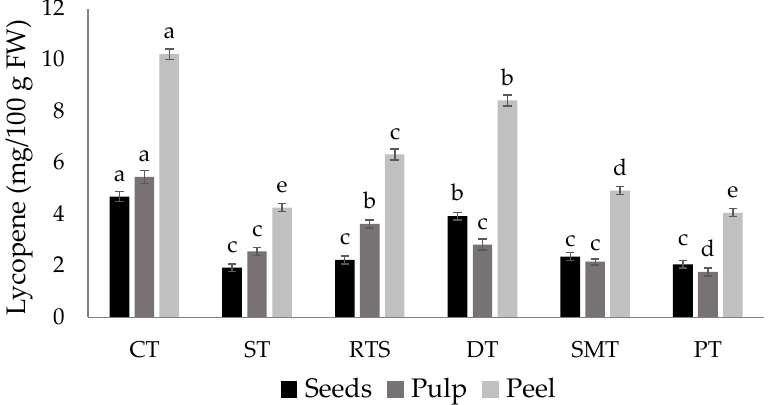
Figure 3. Lycopene content in the seeds, pulp, and peel fractions of each tomato cultivar: Cherry tomato (CT), Smooth round tomato (ST), Round tomato sauce (RTS), Datterino tomato (DT), S. Marzano tomato (SMT), and Piccadilly tomato (PT). The histograms represent mean ± SD. Results were analysed by one-way analysis of variance (ANOVA) followed by Holm-Sidak’s multiple comparisons test. Different letters indicate significant differences within each fraction among different tomato cultivars ( p < 0.001). Table 2. Comparison among lycopene levels in the seeds, pulp, and peel fractions of each